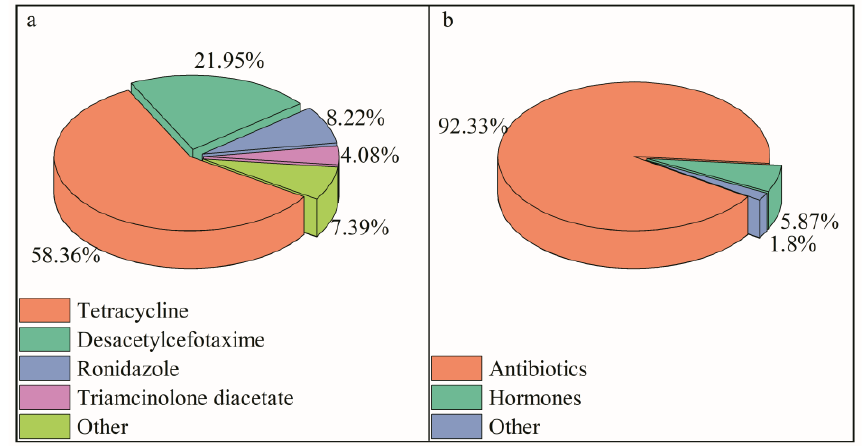
Figure 3. Comparisons of the percentages of various PhACs in snow ( a ) each substance; ( b ) species.